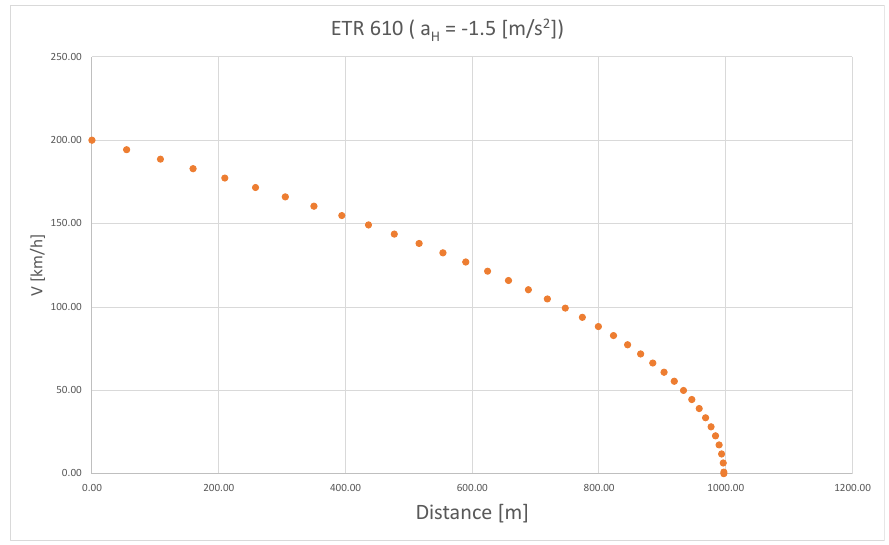
Figure 3. Emergency braking characteristics of the ETR610 (ED250) train.